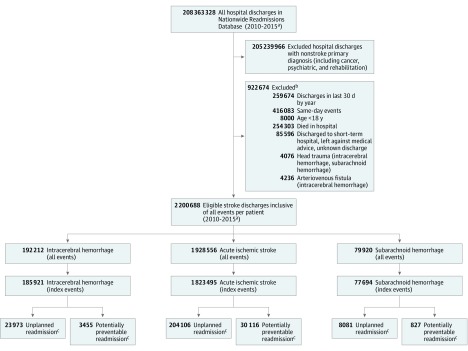
Eligible Stroke Discharges, Reasons for Exclusion, and Proportion of Overall, Unplanned, and Potentially Preventable Stroke-Related Nationwide 30-Day Readmissions Between January 1, 2010, and September 30, 2015The proportion (95% CI) of 30-day overall readmissions among index events for acute ischemic stroke was 12.44% (12.33%-12.55%); intracerebral hemorrhage, 13.70% (13.40%-13.99%); and subarachnoid hemorrhage, 11.48% (11.01%-11.96%). The proportion (95% CI) of unplanned readmissions among 30-day readmissions for acute ischemic stroke was 90.00% (89.74%-90.26%); intracerebral hemorrhage, 94.15% (93.56%-94.70%); and subarachnoid hemorrhage, 90.63% (89.40%-91.73%). The proportion (95% CI) of potentially preventable readmissions among 30-day readmissions for acute ischemic stroke was 13.28% (13.03%-13.53%); intracerebral hemorrhage, 13.57% (12.82%-14.35%); and subarachnoid hemorrhage, 9.27% (8.26%-10.39%).aInclusive of data between January 1, 2010, and September 30, 2015.bReasons not mutually exclusive.cUnplanned and potentially preventable readmissions not mutually exclusive.